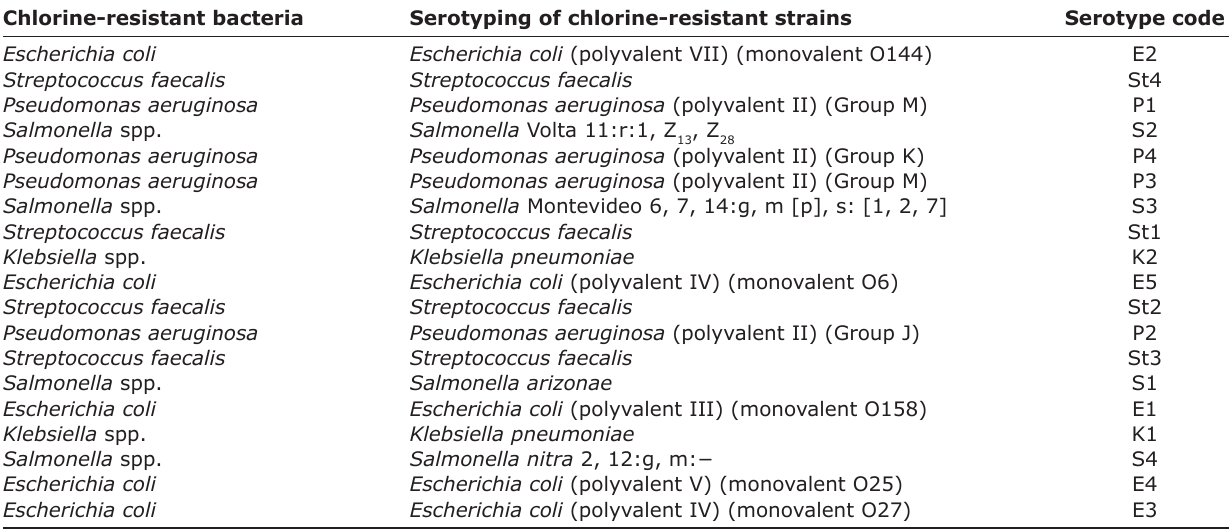
Table-3: Chlorine-resistant strains serotyping with their serotype code. Chlorine-resistant